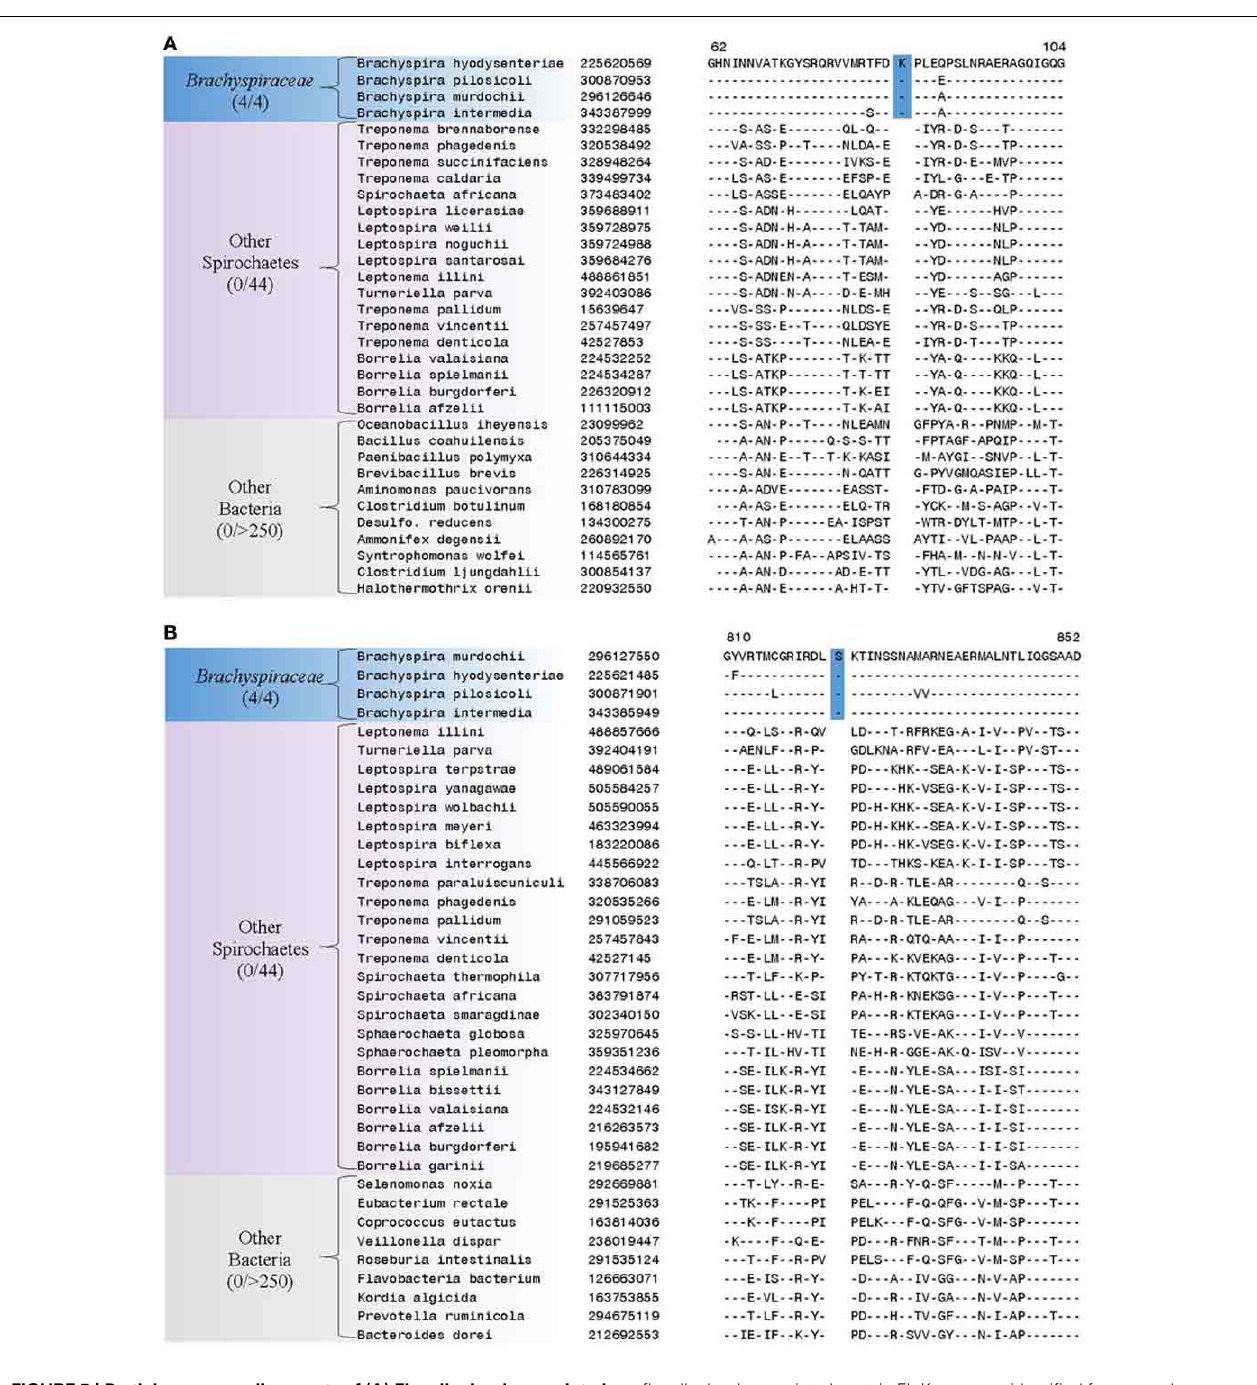
flagellar hook-associated protein FlgK were not identified from members of the genus Sphaerochaeta . Sequence information for other Brachyspiraceae specific CSIs is presented in Supplemental Figures 7–10 and summarized in Table 3